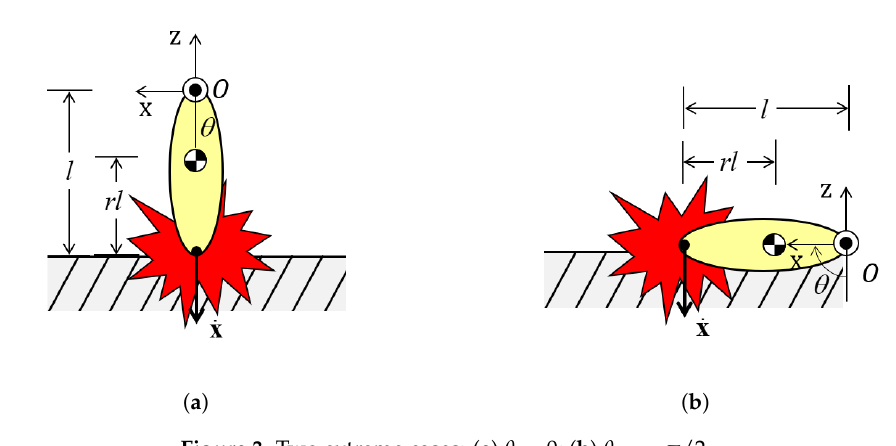
Figure 3. Two extreme cases: ( a ) θ = 0; ( b ) θ = − π